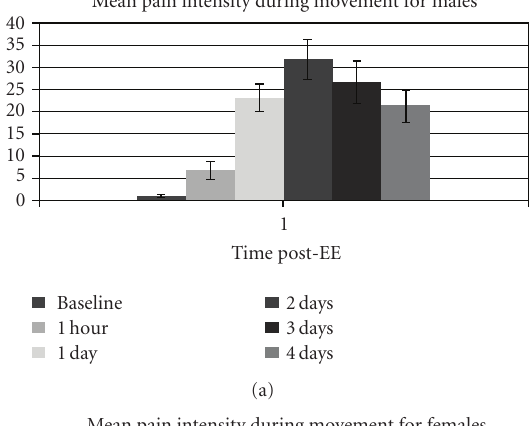
Table 1: Participant characteristics (values are means ± SD).